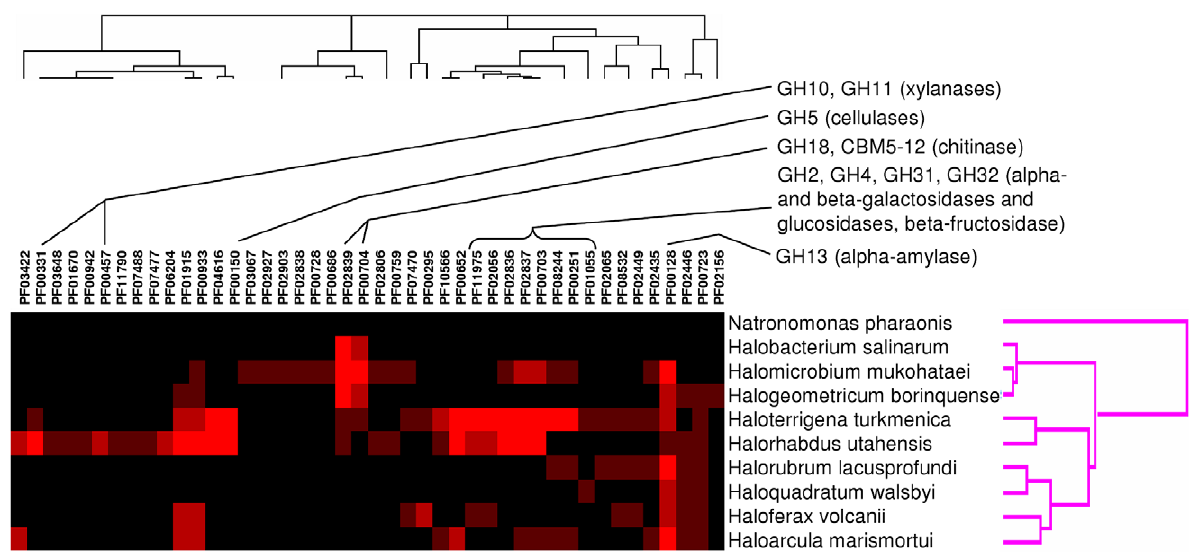
Figure 3. Glycosyl hydrolase distribution in haloarchaeal genomes. The graph shows the results of hierarchical clustering of Halobacteria based on the abundance of Pfam domains corresponding to glycosyl hydrolase families and carbohydrate-binding modules (CBMs). Glycosyl hydrolases and CBMs distinguishing groups of Halobacteria with different nutritional preferences are highlighted.